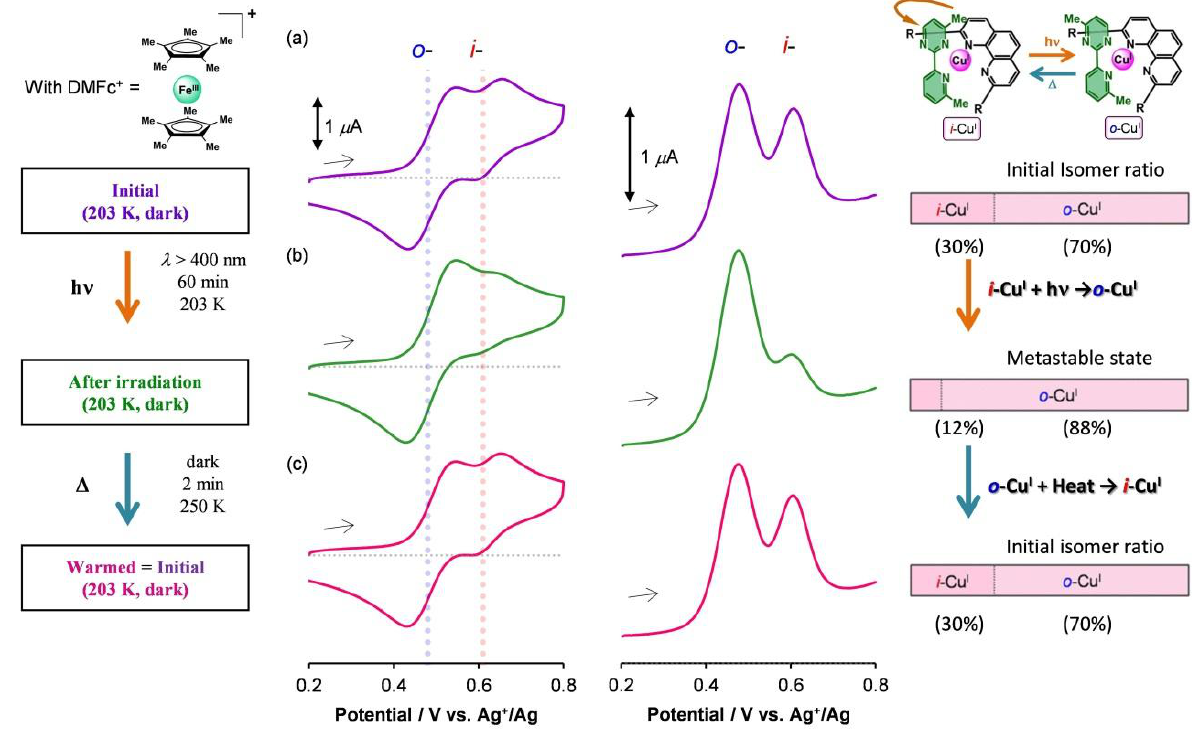
Figure 9. Cyclic voltammograms and differential pulse voltammograms for 1  BF in 0.1 M Bu NBF  dichloromethane containing 1.8 mM DMFcBF 4 4 dark, ( b ) after 60 min of visible-light irradiation (  > 400 nm) at 203 K, and ( c ) after 2 min of heating at 250 K in the dark. The molar ratios of i-Cu I and o-Cu I are represented on the right as horizontal bars. Adapted with permission from [42]. Copyright (2012)